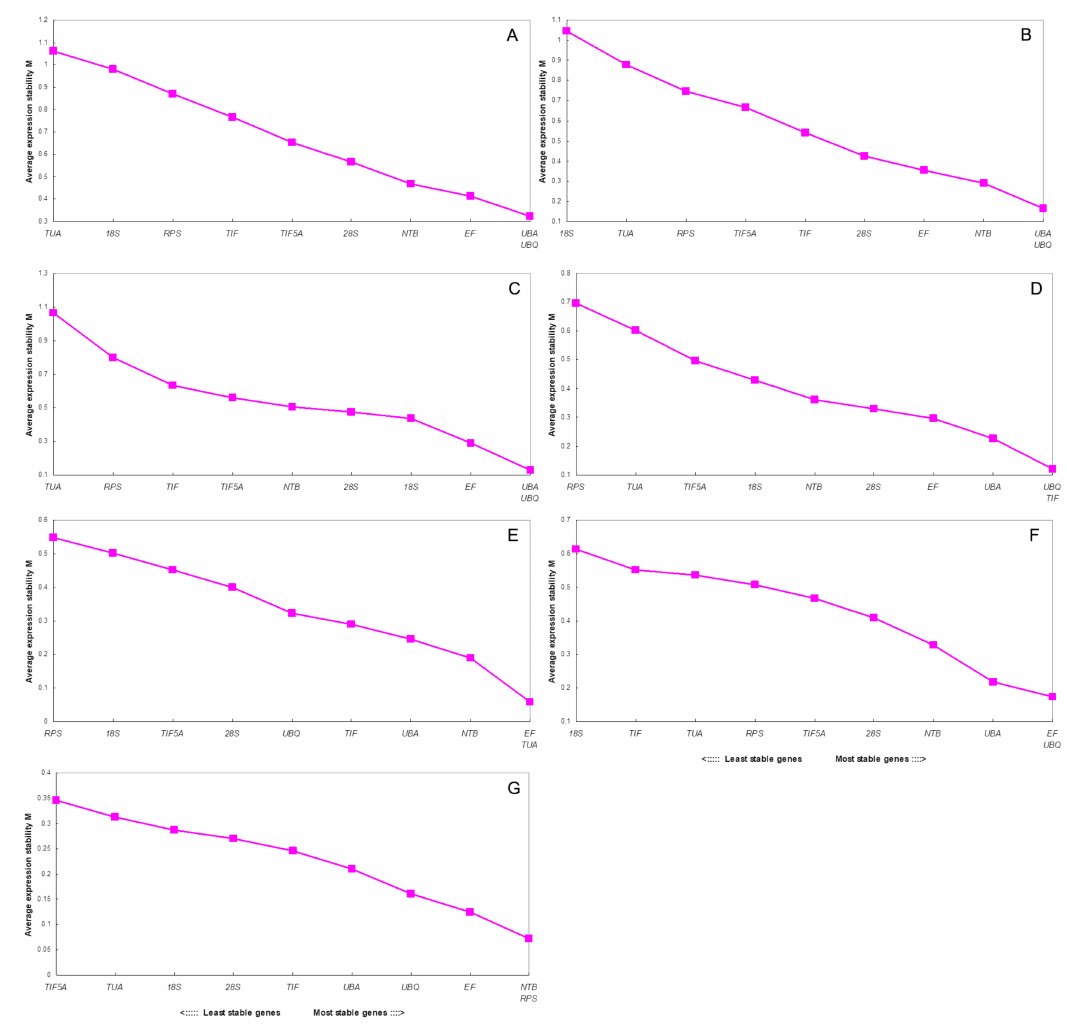
Figure 3. Average expression stability values (M) of 10 candidate reference genes ( 18S, 28S, EF, UBA, UBQ, TIF, NTB, TUA, RPS , and TIF5A ) by GeNorm analysis:( A ) all samples; ( B ) different cultivars; ( C ) different tissues; ( D ) different developmental stages of fruits; ( E ) under cold stress; ( F ) under drought stress and ( G ) under salt